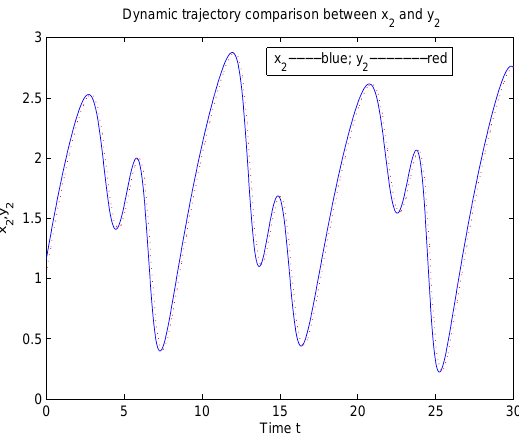
Figure 4. Computer simulations of synchronization between x 1 and y 1 for fractional-order 0.95.